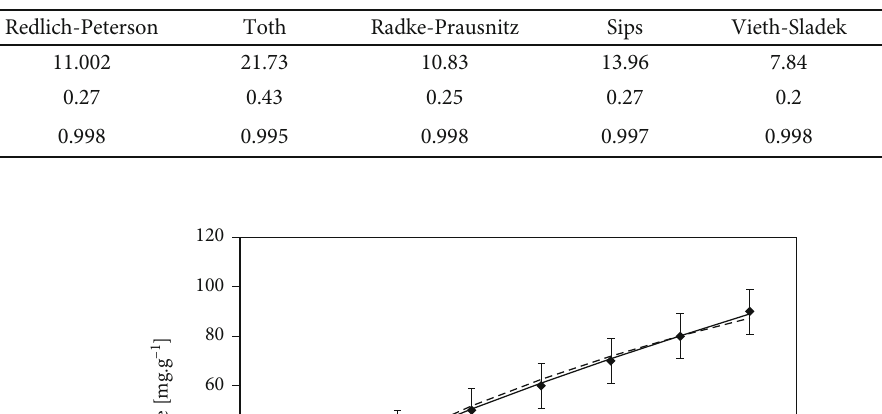
Table 7: Statistical parametric values for 3-parameter isotherms.